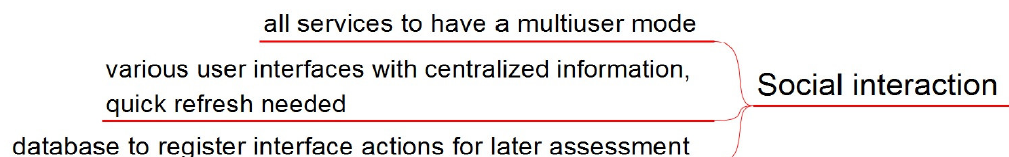
Figure 5. Services requirements for cognitive support in social interaction.